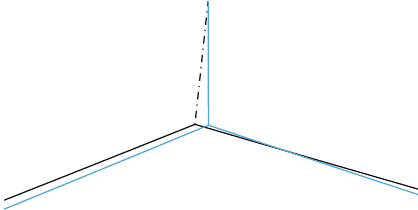
Figure 4: The magnification of local configuration near the left